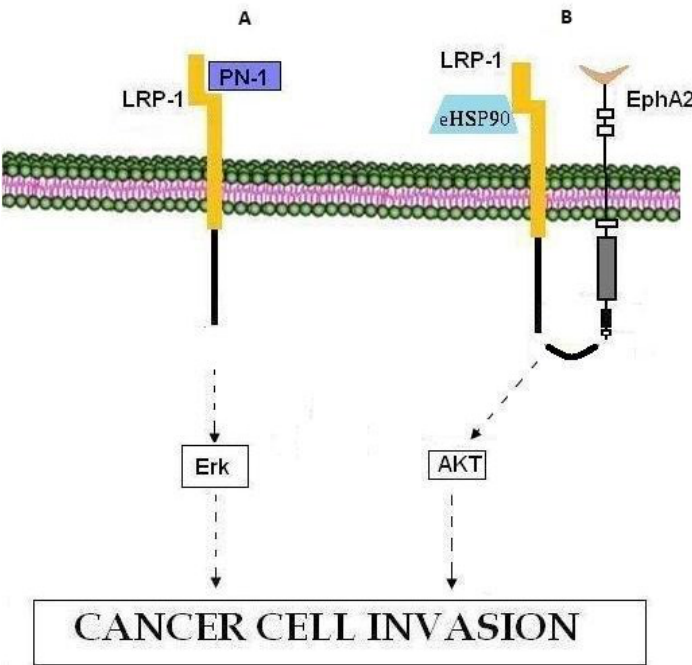
Figure 4. LRP1 involvement in cancer cell invasion. ( A ) PN-1 binding to LRP-1 leads to activation of the Erk signaling pathway and cell invasion. ( B ) The eHSP90-LRP1-EphA2 complex promotes tumor invasion through activation of the AKT signaling